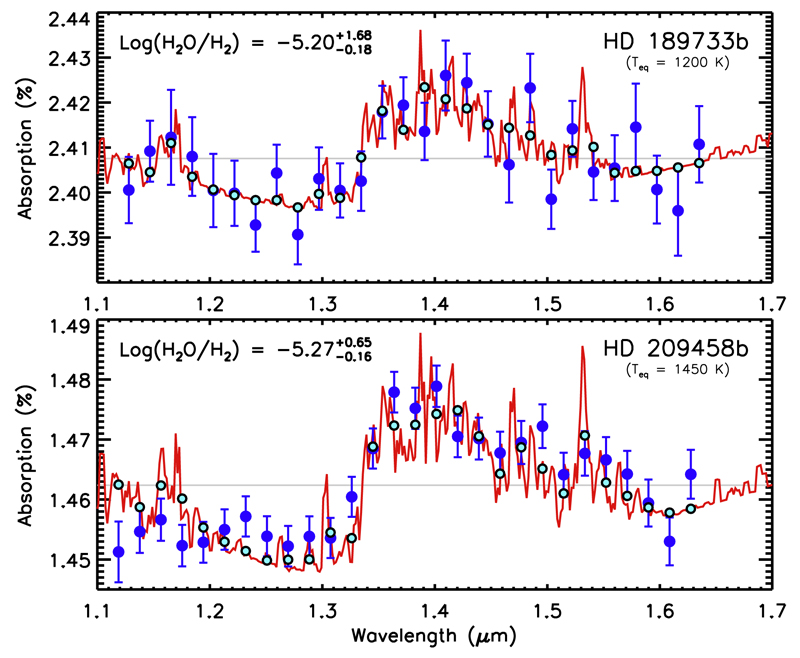
Transmission spectra of two hot Jupiters observed with HST WFC3 (adapted from Madhusudhan et al. 2014b). The vertical axis shows absorption (transit depth). The blue circles show the data: HD 209458b from Deming et al. (2013) and HD 189733b from McCullough et al. (2014). The red curves shows the best-fit model spectra, and the cyan circles show the models binned to the same resolution as the data. The peaks around 1.4 μm show H2O absorption